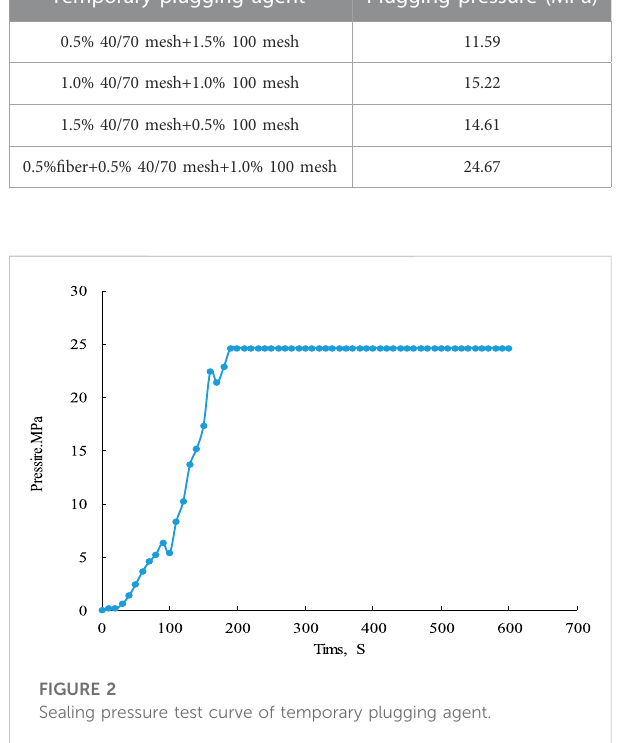
FIGURE 2 Sealing pressure test curve of temporary plugging agent.